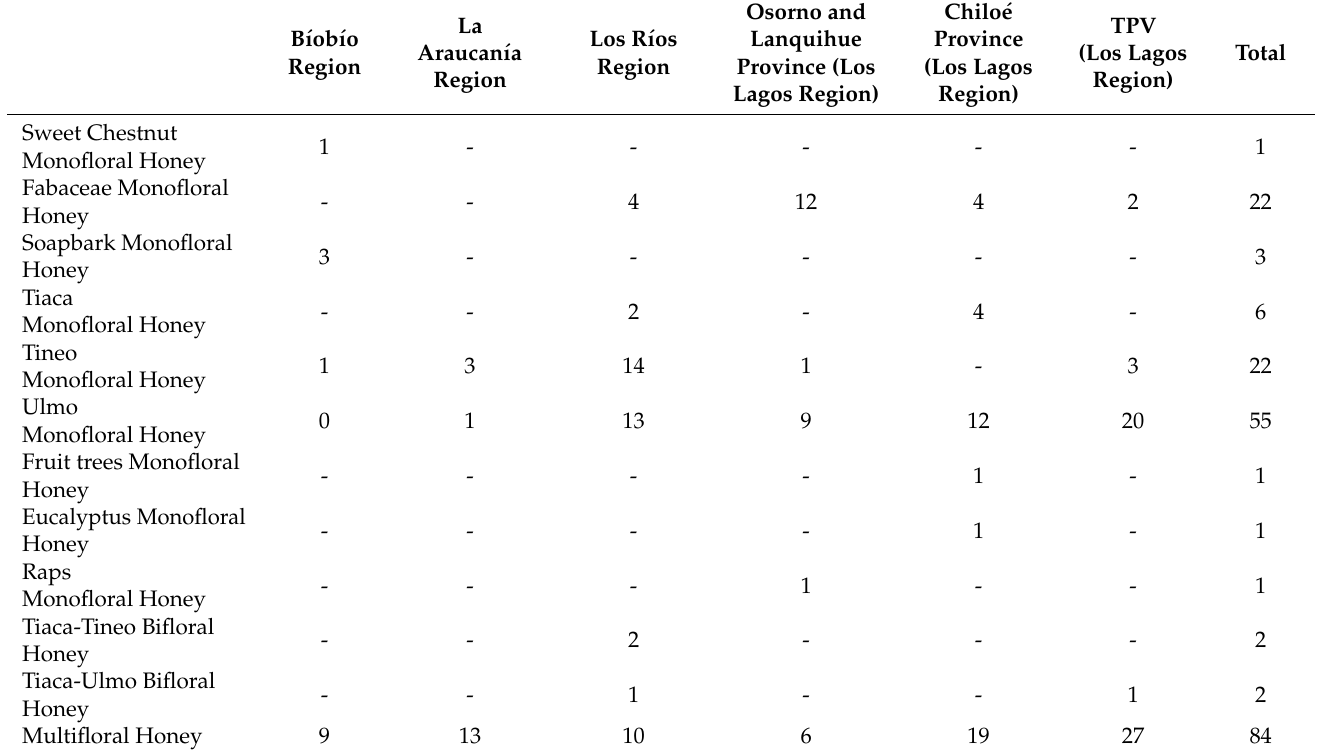
Table 4. Classification and typification of the honey in relation to its percentage of predominant pollen distributed by territory (according to NCh 2981:2005)